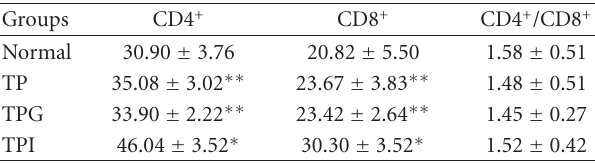
Table 1: Subset of T lymphocytes in the peripheral blood (mean ± SD, %).